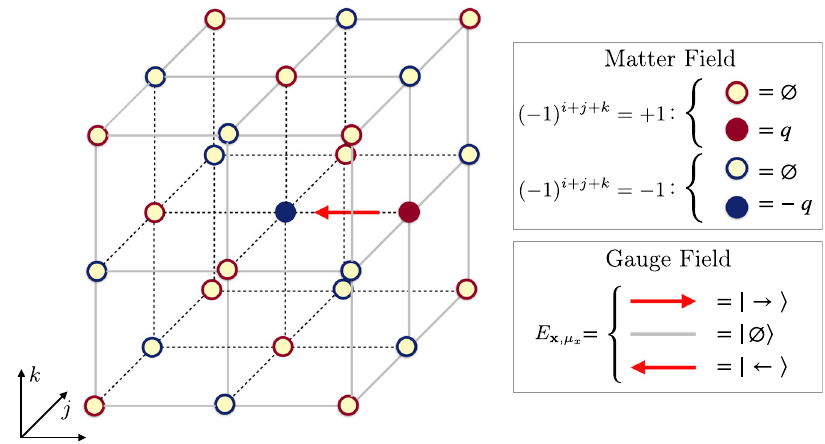
Fig. 1 Scheme of the three-dimensional LGT with three electric fi eld levels (spin-1 compact representation). Fermionic degrees of freedom are represented by staggered fermions on sites with different parity: on the even (odd) sites, a full red (blue) circle corresponds to a particle (antiparticle) with a positive (negative) charge. As an illustrative example, it is shown a gauge-invariant con fi guration of matter and gauge fi elds with one particle and one antiparticle in the sector of zero total